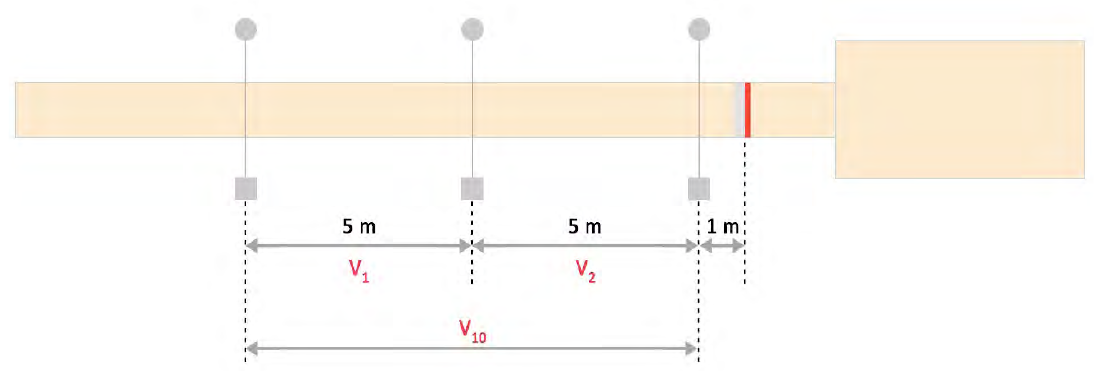
Figure 1. Placement of photocells on the long jump runway Table 1. Mean and standard deviation values of the age, jumping distance and velocity variables for the sample